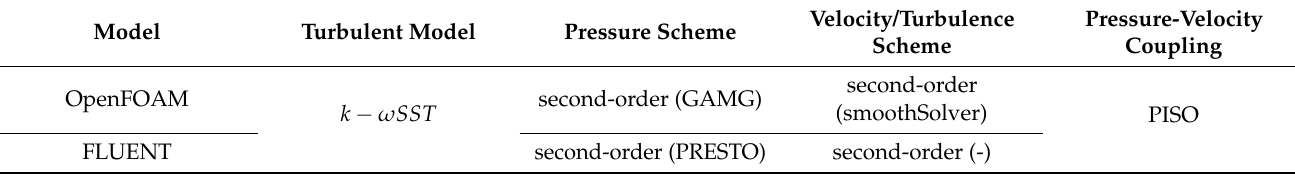
Table 2. Setup of numerical